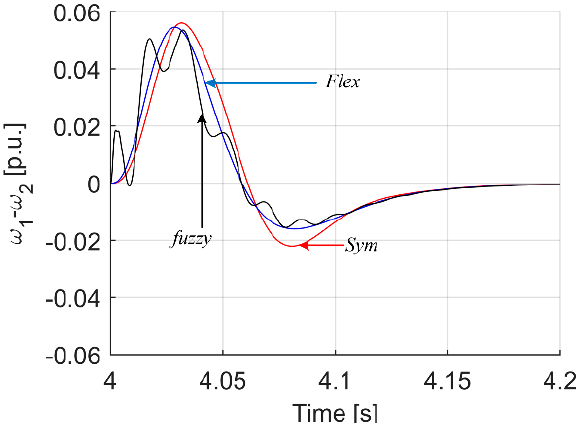
Figure 13. Transients of difference between motor and reference speed for analyzed controller cases.